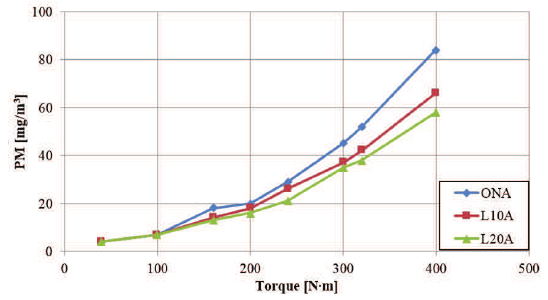
Fig. 9. NO x concentration for injection timing B and n = 2000 rpm